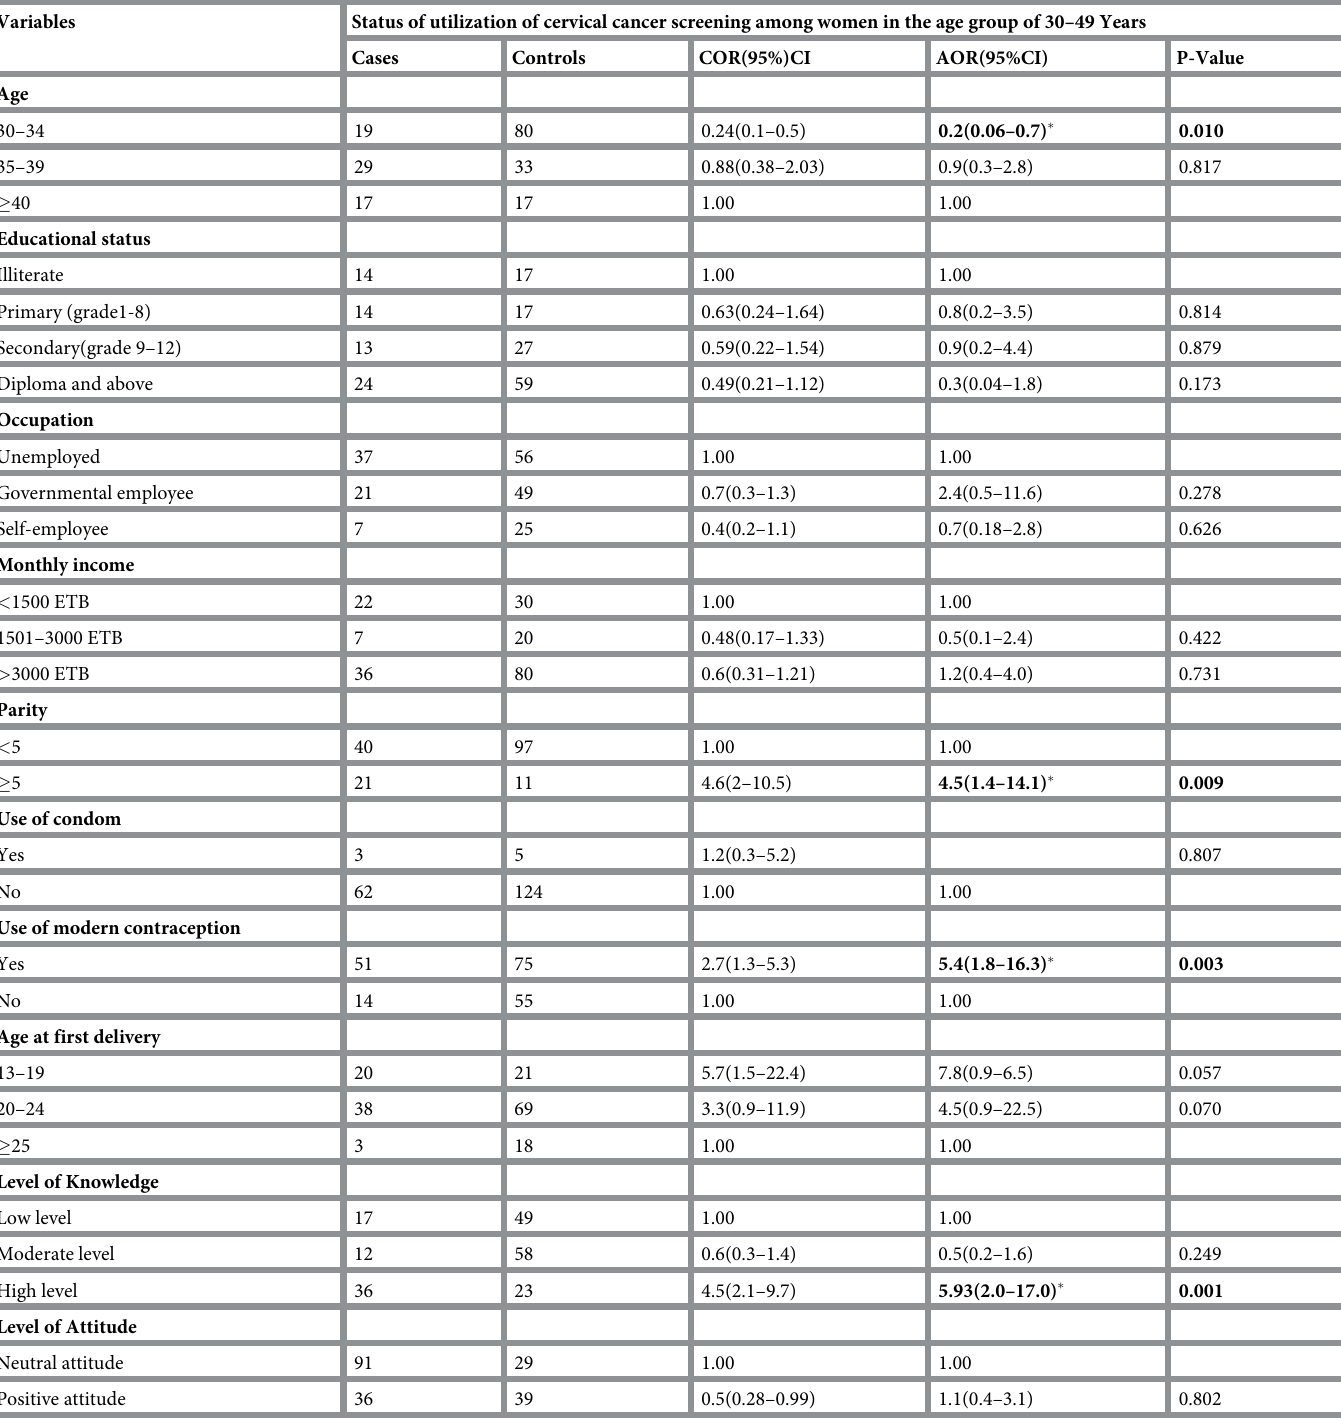
Table 3. Determinant of utilization of cervical cancer screening among women in the age group of 30–49 in Ambo town, Oromia Regional State, Ethiopia.